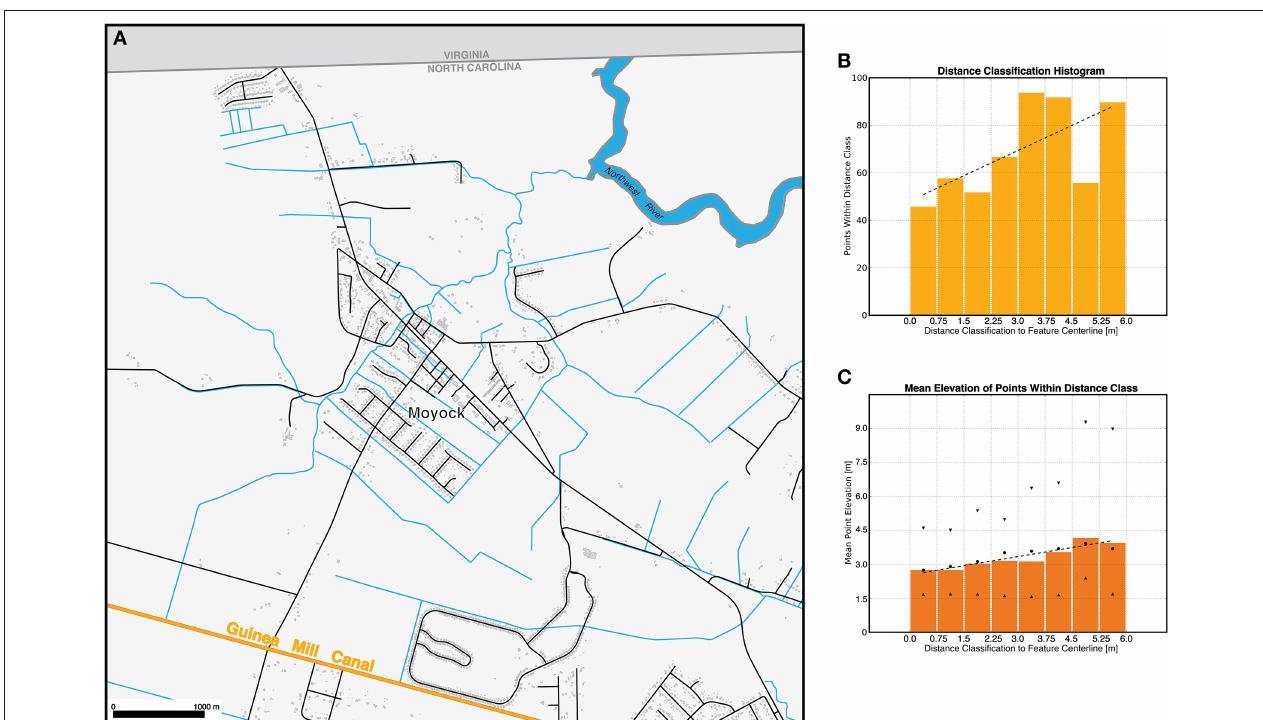
FIGURE 3 | Map inset (A) depicts a subset area of Moyock including all ditches, canals, and riverine hydrography (blue), roads (black), and buildings (grey) with the large Guinea Mill Canal highlighted to illustrate subsequent LiDAR point and buffer analyses; inset chart (B) histogram shows the number of points (y-axis) vs. multiple buffer distances of the Guinea Mill Canal centerline (x-axis), an analysis that was conducted on all ditched features; and the chart (C) illustrates the elevation variation of LiDAR points with distance from the centerline of Guinea Mill Canal, highlighting a best-fit OLS regression relationship used in selecting an optimal buffer distance to preserve minimum elevation for attributing the